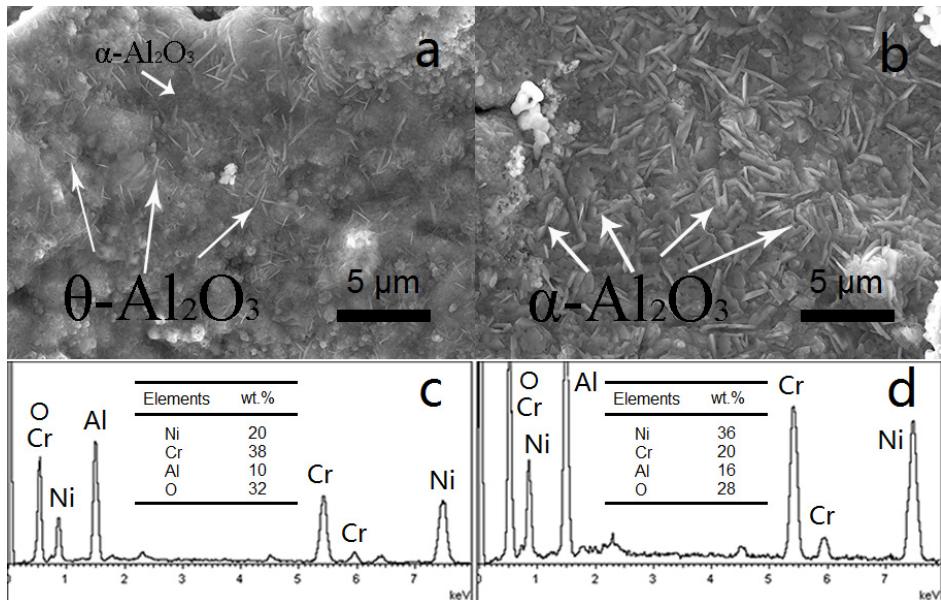
Figure 5. Surface morphology of the bondcoat samples after oxidation for 1 h at 1200 °C ( a ) as-sprayed sample, ( b ) Al coated sample; and EDX spectrum ( c ) as-sprayed sample, ( d ) Al coated sample.